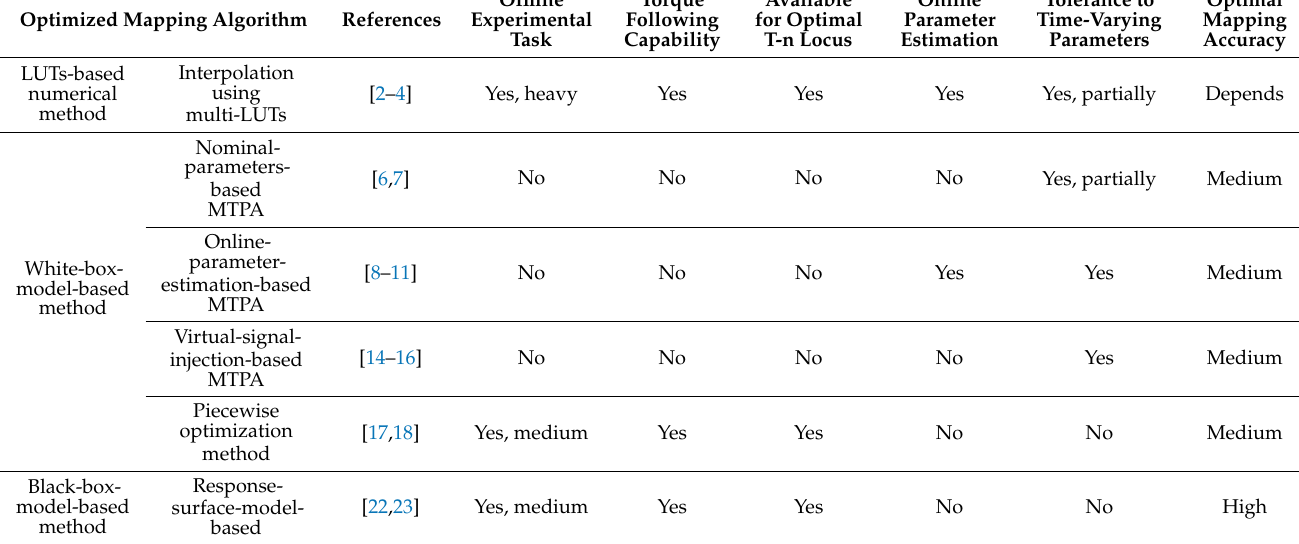
Table 1. Summary of existing current–torque optimization mapping